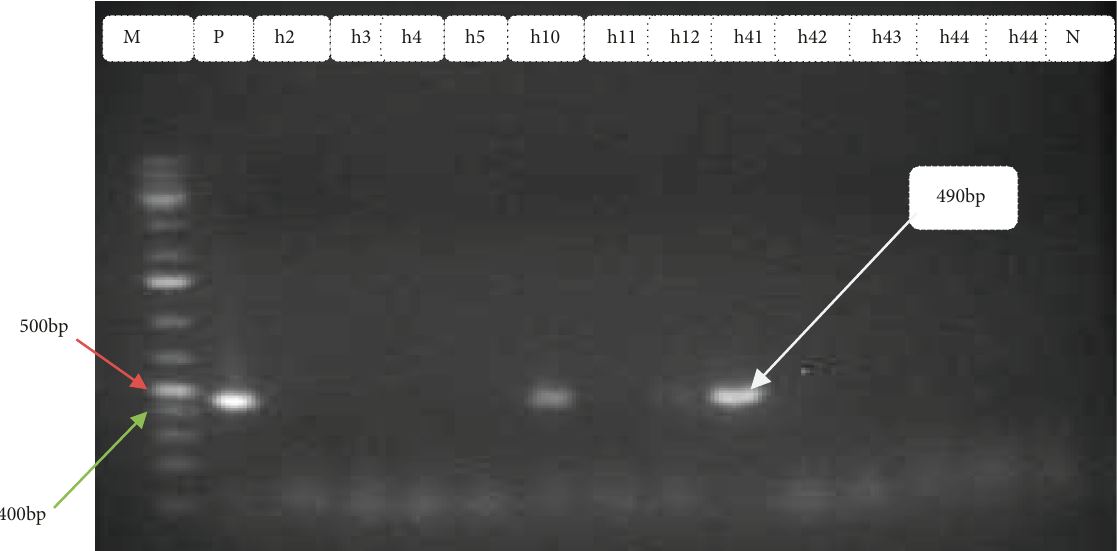
Figure 2: Amplification of eae gene in Escherichia coli isolates from diarrheic children: M Marker (100 bp DNA ladder) P positive control, Lane No. h10 and h41 indicate positive samples, Lane No. h2-h5, and h43-h44 indicates negative samples and N negative control.